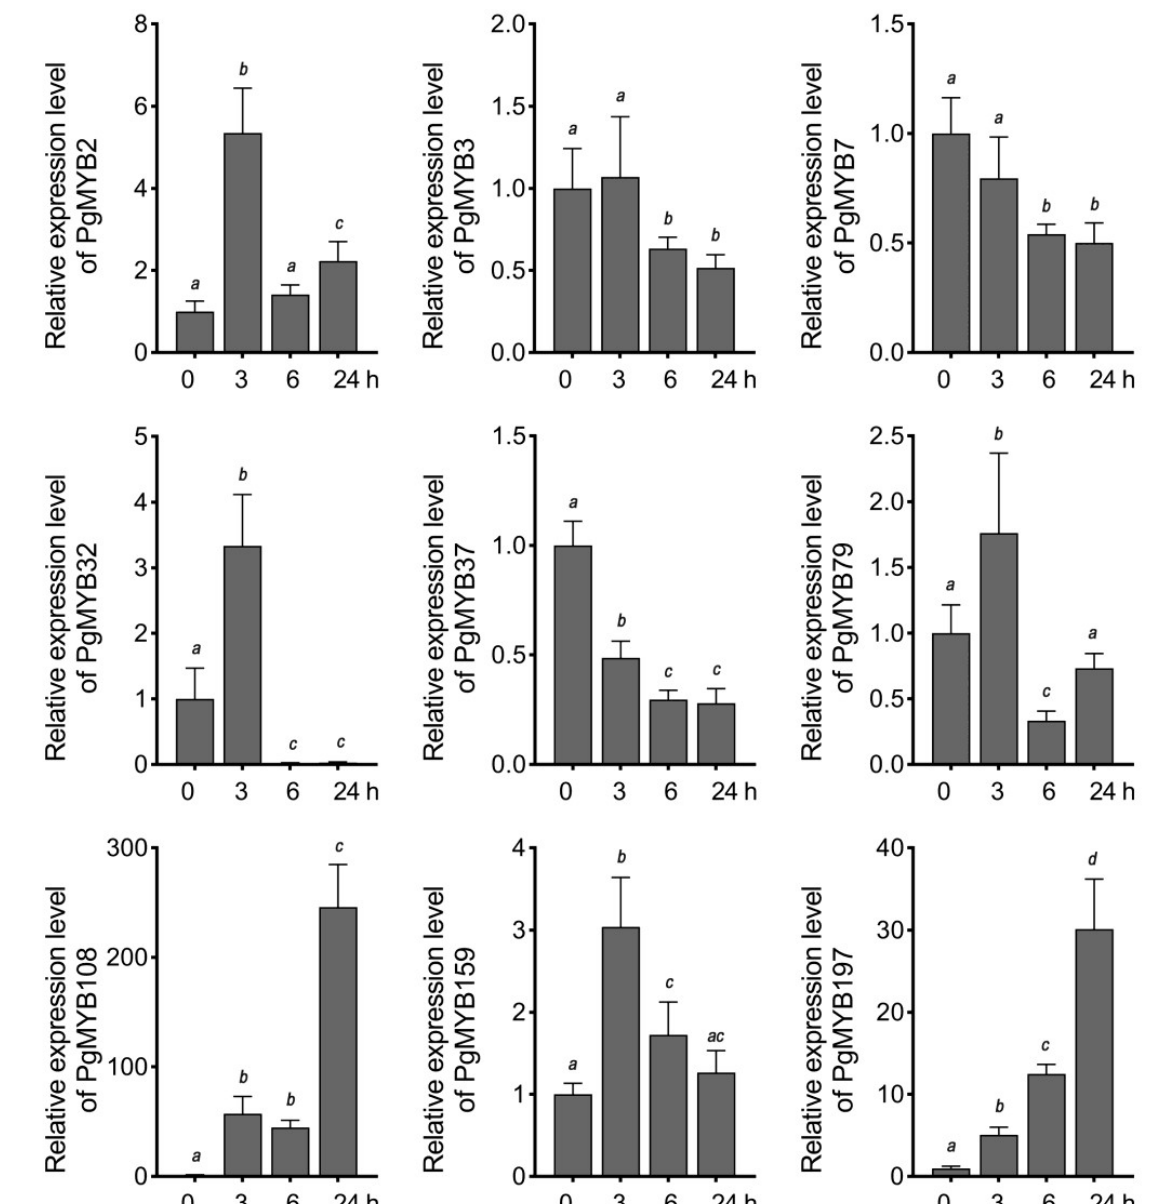
Figure 6. Expression analysis of nine R2R3-type PgMYB genes in response to ABA treatment. Three-week-old hydroponically grown seedlings were treated with 100 µ M ABA. Shoot tissues were harvested at each indicated time point. Expression level of each PgMYB gene at 0 h is set as control. The data represent the mean values of three replicates ± SD. Statistical significance of differences was tested by one-way ANOVA analysis ( p < 0.05) and is indicated by lower case letters.